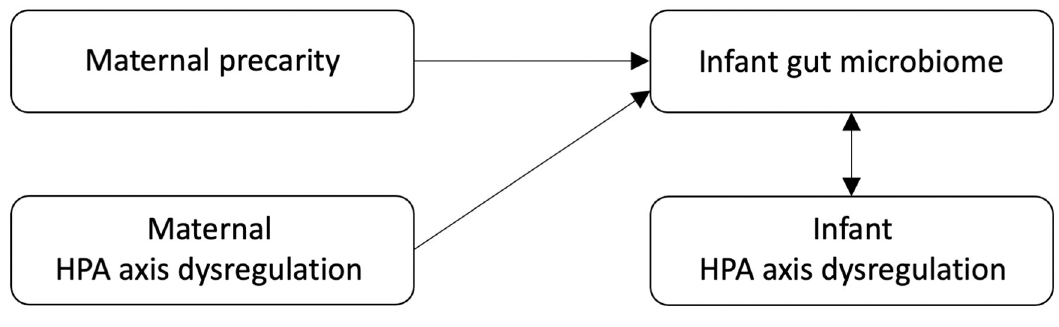
Fig 1. Conceptual